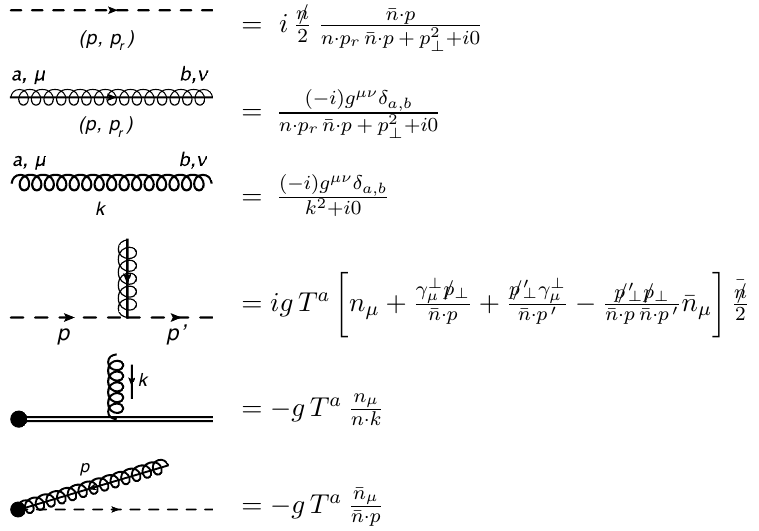
Figure 1 . Feynman rules for the leading-power SCET I Lagrangian and operators: collinear quark and gluon propagator with label p and residual momentum p r , soft gluon propagator, coupling of collinear quark and gluon, emission from a soft ( Y n ) and collinear ( W n ) Wilson line,